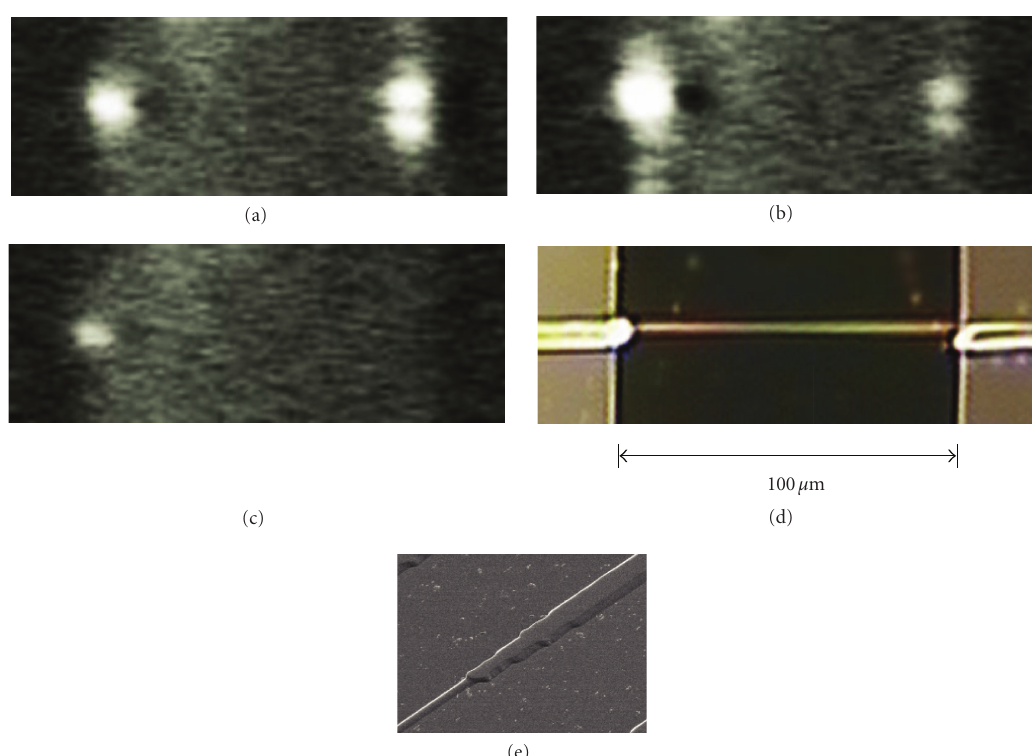
Figure 4: Images from the near infrared camera showing a top-down view of the sample centered on the DLSPPW part of the waveguide. Left side is the incoupling, right side is the outcoupling. (a) 0 ◦ Polarization (b) 45 ◦ Polarization (c) 90 ◦ Polarization. While the incoupling spot stays bright, the outcoupling spot rapidly decreases in intensity, showing that the plasmonic mode is suppressed with changing polarization. (d) Optical microscope image of waveguide showing gold stripe and DLSPPW section shown for comparison. (e) SEM image (same scale as optical images) showing the transition from plasmonic to optical waveguide at an angle of 45 ◦